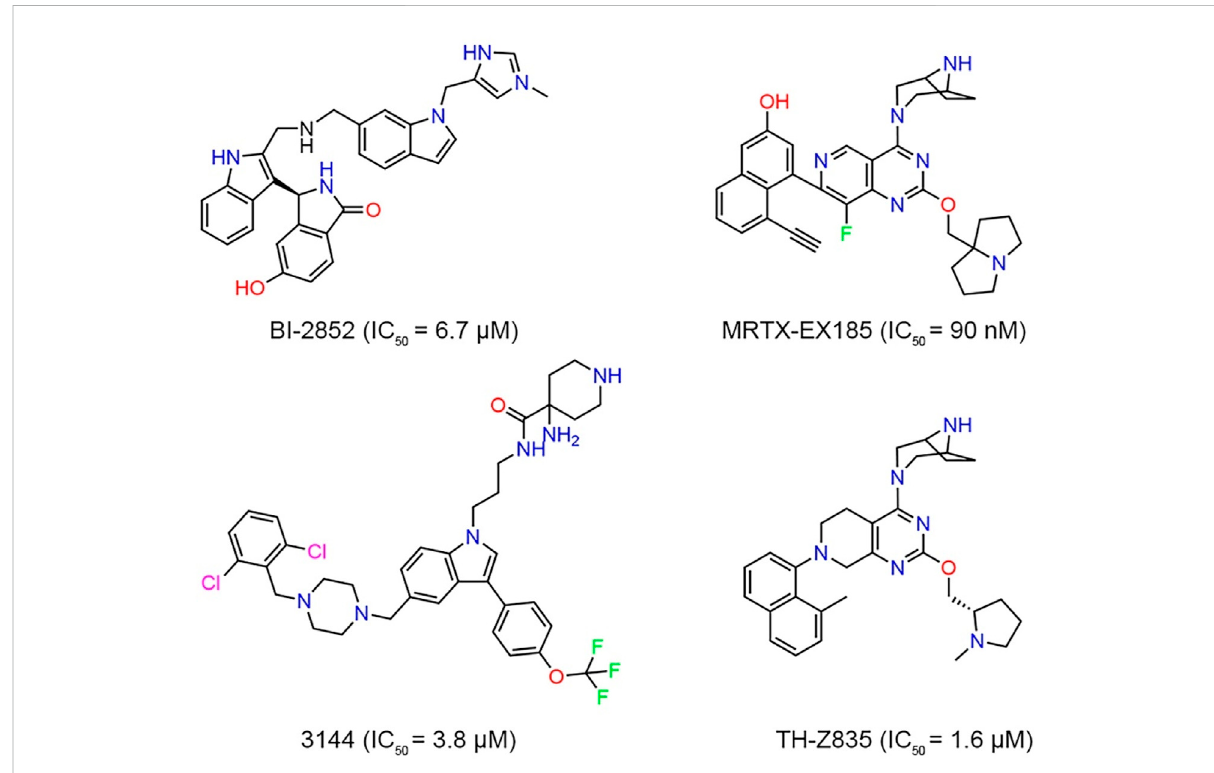
FIGURE 1 The chemical structures and biological data of known inhibitors of KRAS G12D